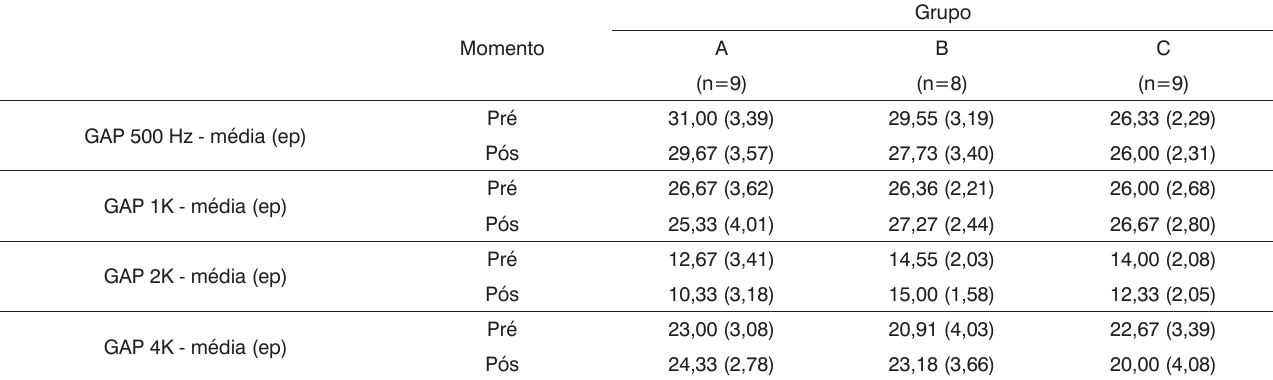
Tabela 3. Diferença entre os limiares auditivos nas vias aérea e óssea ( gap ) - médias e erros padrão (ep) ajustados para depen- dência entre as medidas do mesmo paciente. Momento